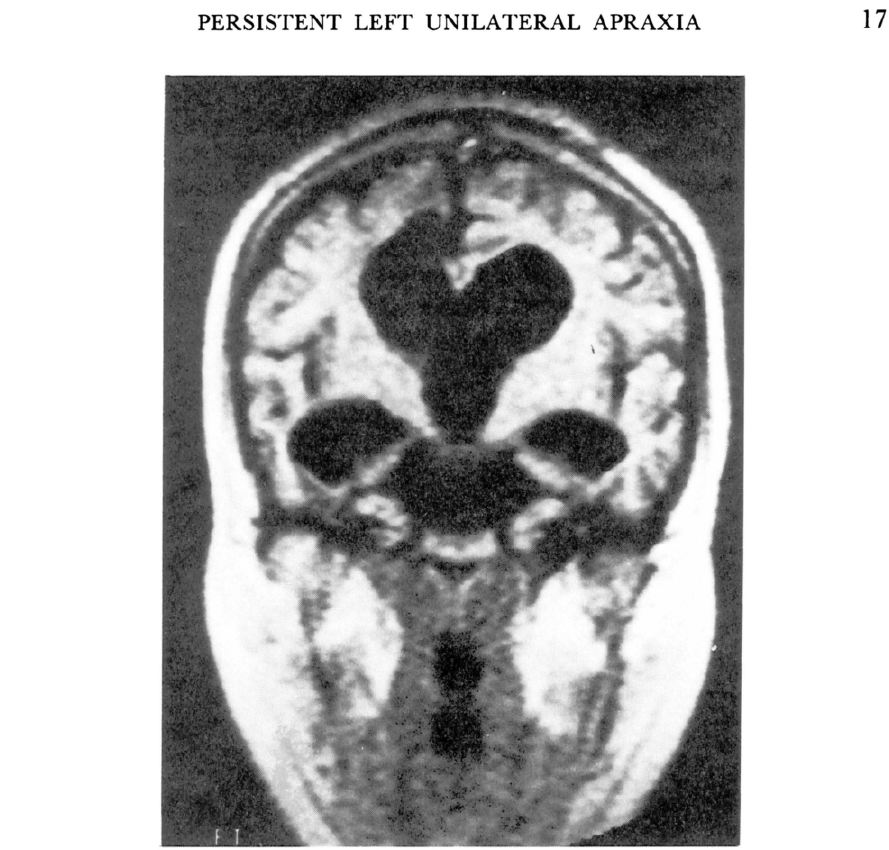
FIG. 2. Same MRI image of coronal section at a plane where callosal lesion is